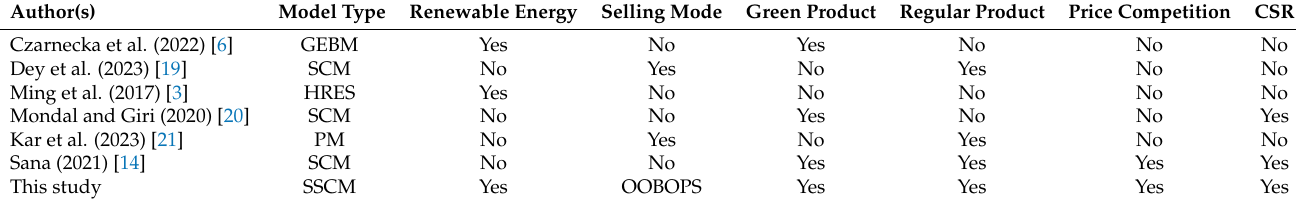
Table 1. Study contributions along with research